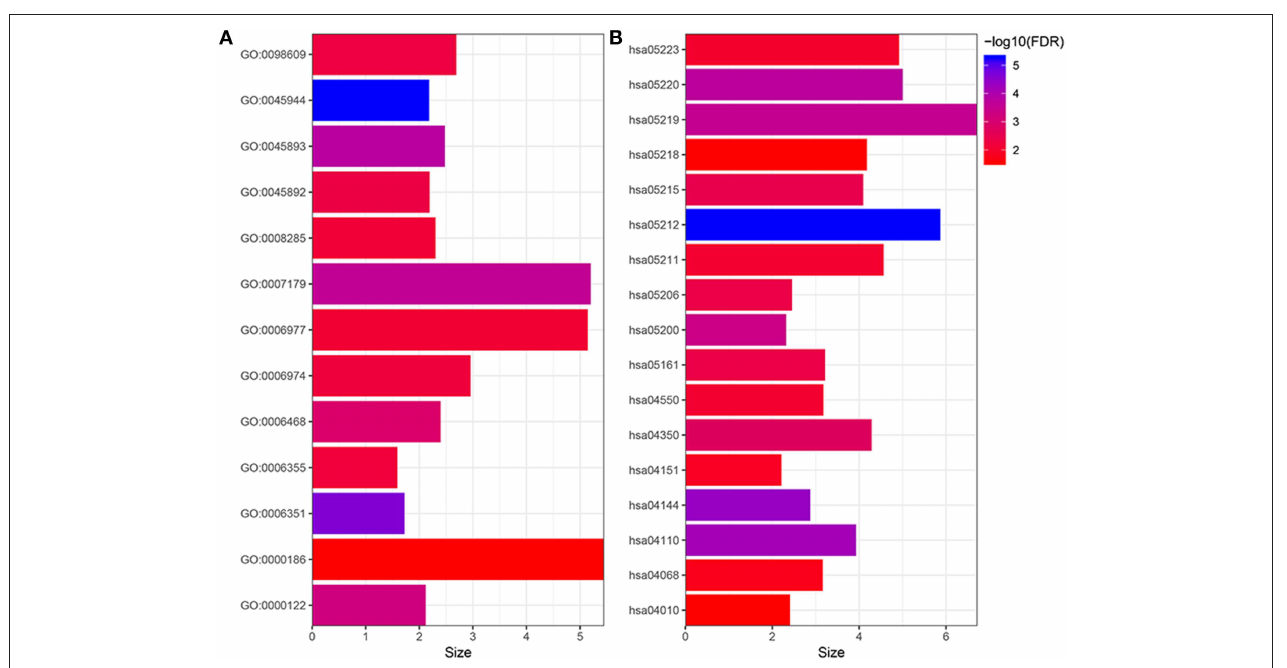
FIGURE 4 | Gene ontology (A) and KEGG enrichment (B) analysis of the targets. GO:0045944, positive regulation of transcription from RNA polymerase II promoter; GO:0006351, transcription, DNA-templated; GO:0045893, positive regulation of transcription, DNA-templated; GO:0007179, transforming growth factor beta receptor signaling pathway; GO:0000122, negative regulation of transcription from RNA polymerase II promoter; GO:0006468, protein phosphorylation; GO:0045892, negative regulation of transcription, DNA-templated; GO:0098609, cell-cell adhesion; GO:0006974, cellular response to DNA damage stimulus; GO:0006355, regulation of transcription, DNA-templated; GO:0008285, negative regulation of cell proliferation; GO:0006977, DNA damage response, signal transduction by p53 class mediator resulting in cell cycle arrest GO:0000186, activation of MAPKK activity; hsa05212, Pancreatic cancer; hsa04144, Endocytosis; hsa04110, Cell cycle; hsa05220, Chronic myeloid leukemia; hsa05219, Bladder cancer; hsa05200, Pathways in cancer; hsa04350, TGF-beta signaling pathway; hsa05215, Prostate cancer; hsa05206, MicroRNAs in cancer; hsa05161, Hepatitis B; hsa04550, Signaling pathways regulating pluripotency of stem cells; hsa05211, Renal cell carcinoma; hsa05223, Non-small cell lung cancer; hsa04151, PI3K-Akt signaling pathway; hsa04068, FoxO signaling pathway; hsa05218, Melanoma; hsa04010, MAPK signaling